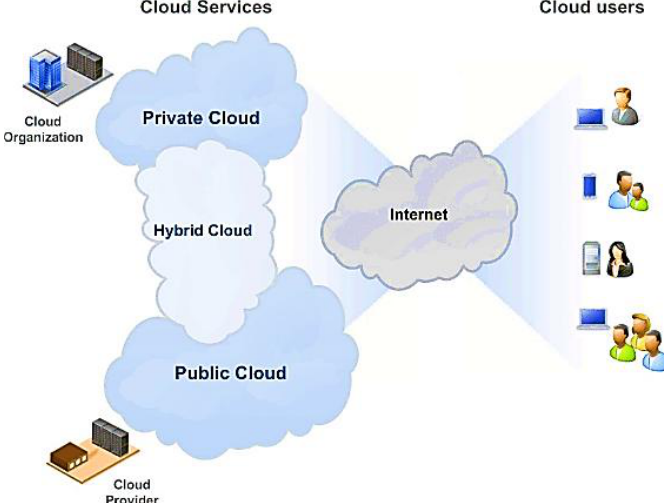
Figure 1. Important structural design of